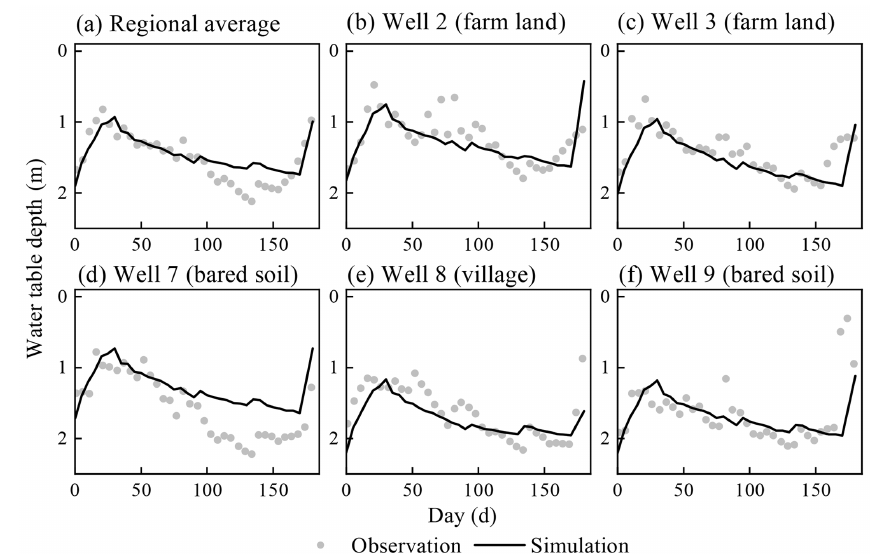
Figure 10. Comparison between simulated and observed water table depth of the real-world